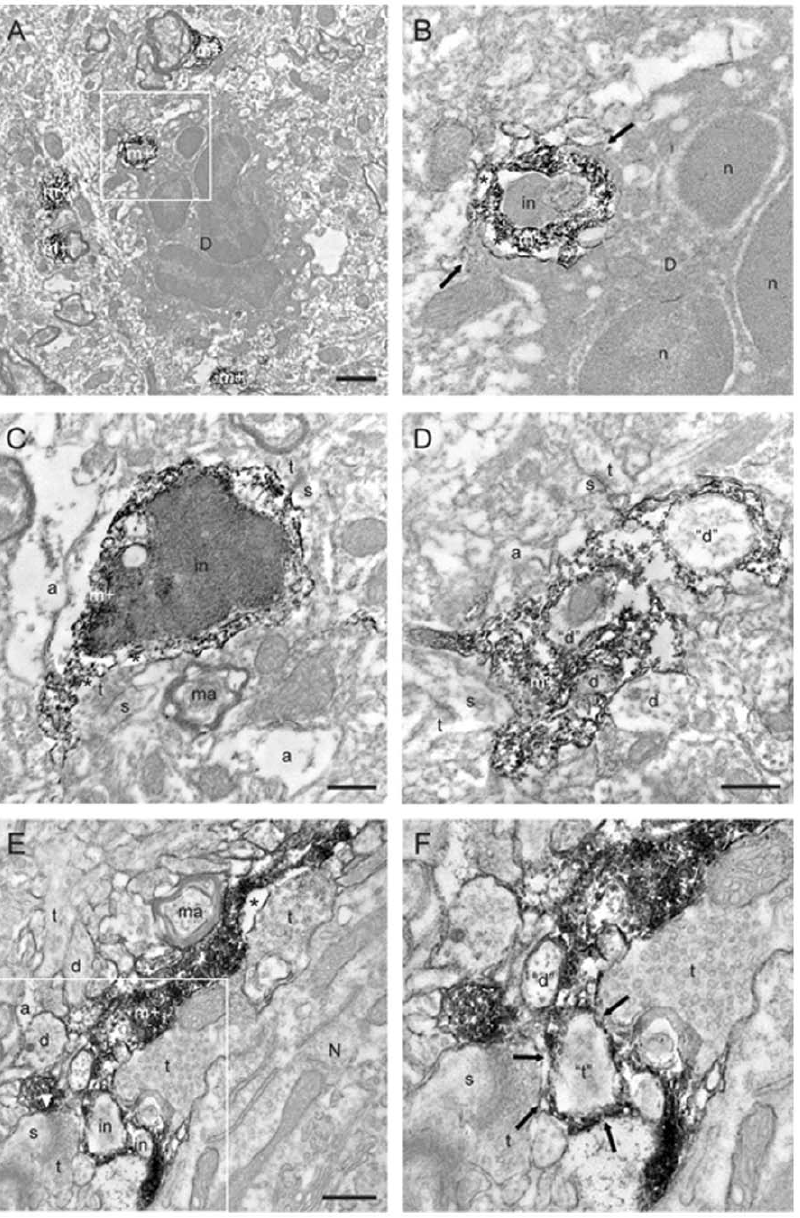
Figure 10. Tat alters ultrastructural relationships between polymorphonuclear granulocytes, microglia and neuronal elements including synapses in the cerebral cortex of CX 3 CR1 + / 2 mice. This is a montage of electron micrographs 24 hrs (Panels A–D) or 7 d (Panels E, F) after Tat injection (n=3 independent replicates). Panels A and B show a polymorphonuclear granulocyte (pmn) cell body in apposition to a microglial process. Panel B presents a higher resolution view of the boxed region in Panel A Two processes arising from the degenerating polymorphonuclear granulocyte (arrows) surround an Iba-1 immunopositive microglial process (m + ) with a cellular inclusion (in). Panel C presents another example of microglial process with a cellular inclusion. In both Panels B and C, the cellular inclusion appears as engulfed material from degenerating neurons. In Panel D, a microglial process contains three cellular inclusions resembling profiles of dendrites (‘‘d’’). Direct contacts with other synaptic elements including dendritic spines (s) and axon terminals (t) are also observed. Panel E shows a microglial process displaying a cellular inclusion resembling an axon terminal (‘‘t’’; arrows), as well as cellular inclusions resembling a dendrite, suggesting their phagocytic engulfment by microglia after HIV infection. Panel F presents a higher resolution view of the boxed region in Panel E. a, astrocytic process; d, dendrite; ma, myelinated axon; n, nucleus; N, neuron; *, extracellular space; scale bars, 1 m m (Panel A) and 0.5 m m (Panels C–E).